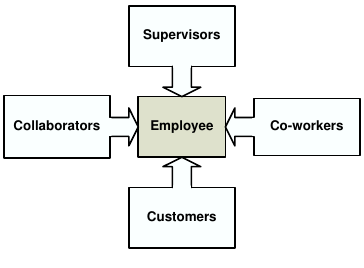
Fig. 1. Different points of view in integral